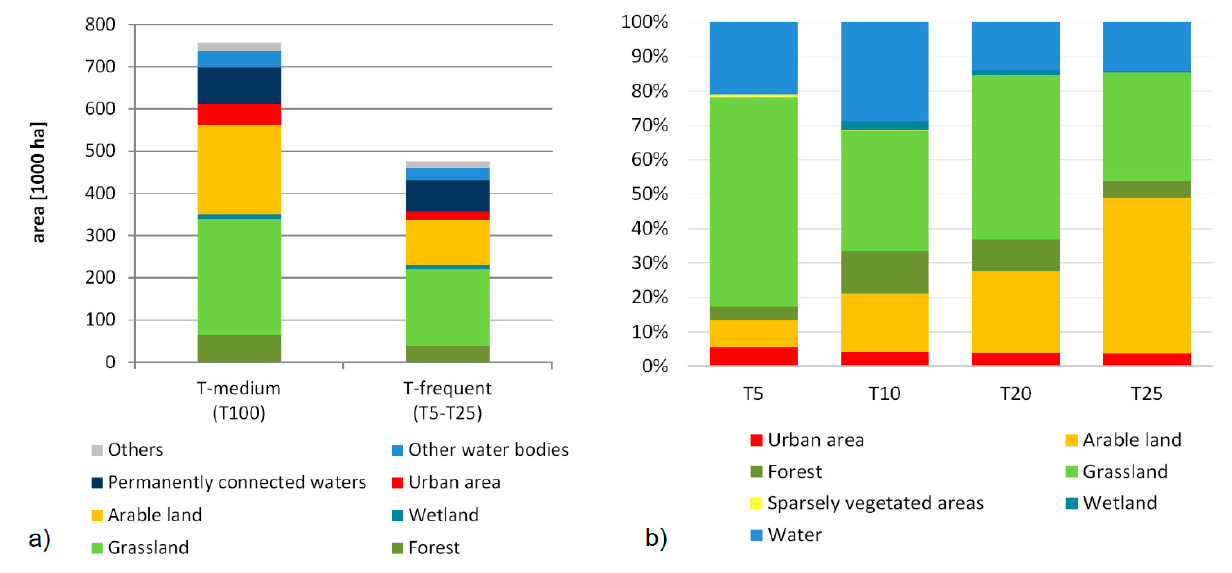
Figure 6. ( a ) Land use in frequent and medium FHM (T-frequent and T-medium). ( b ) Land use in T-frequent differentiated according to the flooding frequencies modelled at different sites.